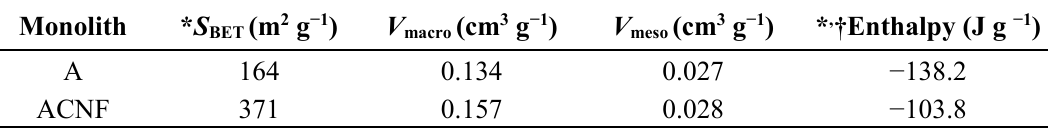
Figure 14. ( a ) Photograph of both γ -Al 2 O 3 and CNF coatings on a cordierite monolith. SEM micrographs of the ACNF monolith: ( b ) cross-section of a monolith channel and ( c ) detail of CNF grown in situ . Table 6. Textural characteristics of the monolithic supports.